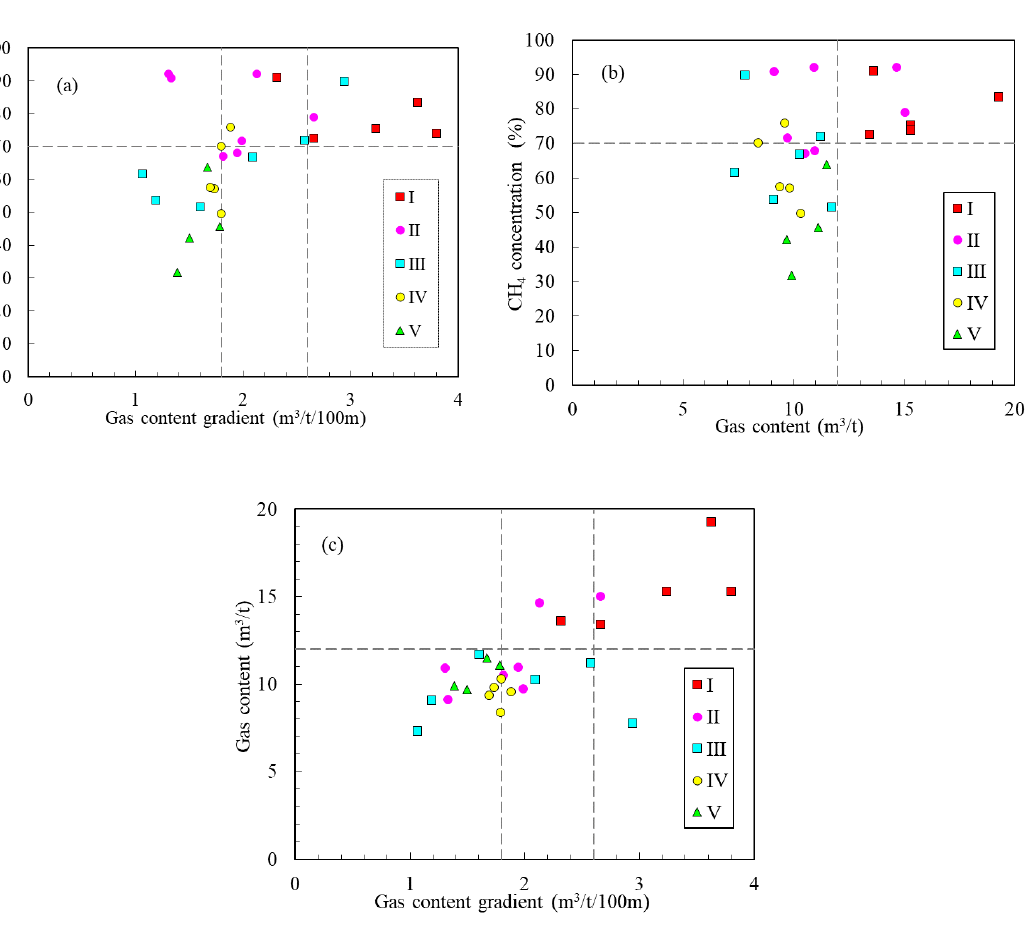
Figure 6. Scatter diagram of gas-bearing property parameters of 5 gas controlling pattern. ( a ) plot of methane concentration to gas content gradient; ( b ) plot of methane concentration to gas content; ( c ) plot of gas content to gas content gradient. Gas controlling pattern: I—reverse fault sealing type, II—syncline sealing type, III—monoclinal enrichment type, IV—normal fault dispersion type, V—buried floor fault dispersion type.